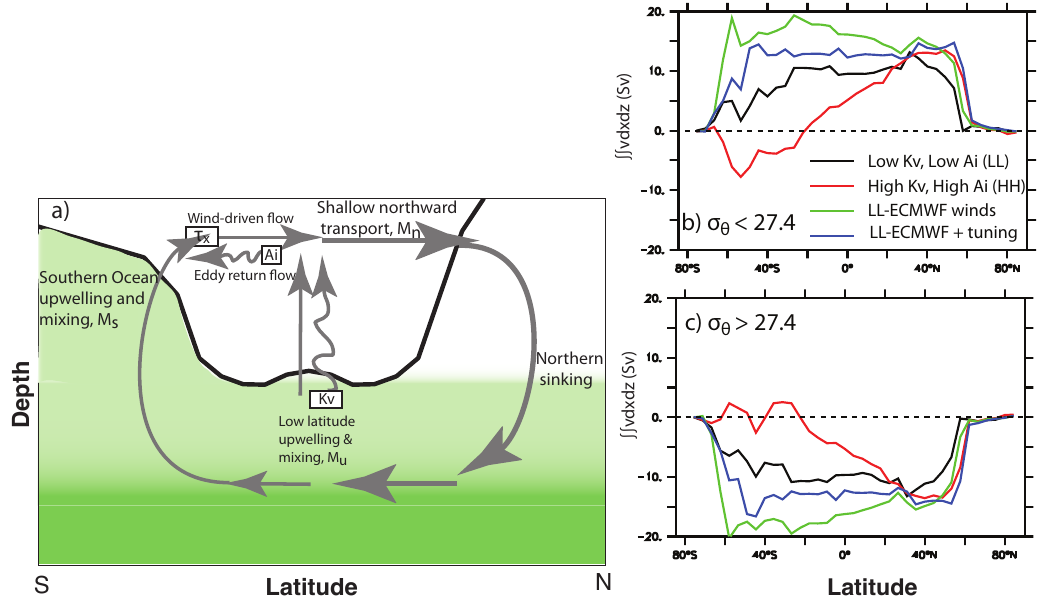
Fig. 2. Schematic of the simple analytical model of the Meridional Overturning Circulation (MOC) and the model results of the MOC. (a) Adapted from Gnanadesikan (1999), the schematic of the flows (gray arrows) which comprise the MOC and their driving mechanisms (boxed text). The black line schematizes the global pycnocline, below which nutrient-rich water is found, represented by green shading. The sinking of water masses in the Northern Hemisphere is balanced by the sum of the Southern Ocean upwelling ( M s ) and low latitude upwelling ( M u ). The rate of Southern Ocean upwelling is set by the wind stress over the Southern Ocean ( τ x ) and the eddy return flow, which is determined largely by the GM coefficient ( A i ). The low latitude upwelling is driven by the downward mixing of heat, which is set by the vertical mixing coefficient ( κ v ). (b) The zonally integrated meridional transport above the 27.4 isopycnal (northward is positive) for each of the four models described in Table 1. (c) The same as panel (b), but below the 27.4 isopycnal. By design, panels (b) and (c) are mirror images of one another because the total transport sums to zero for the volume-conserving ocean of the GCMs. A meridional increase in the meridional transport above (below) the 27.4 isopycnal signals the upwelling (downwelling) of water across the 27.4 isopycnal. The four models are described in Sect. 2.2 of the text and in Table